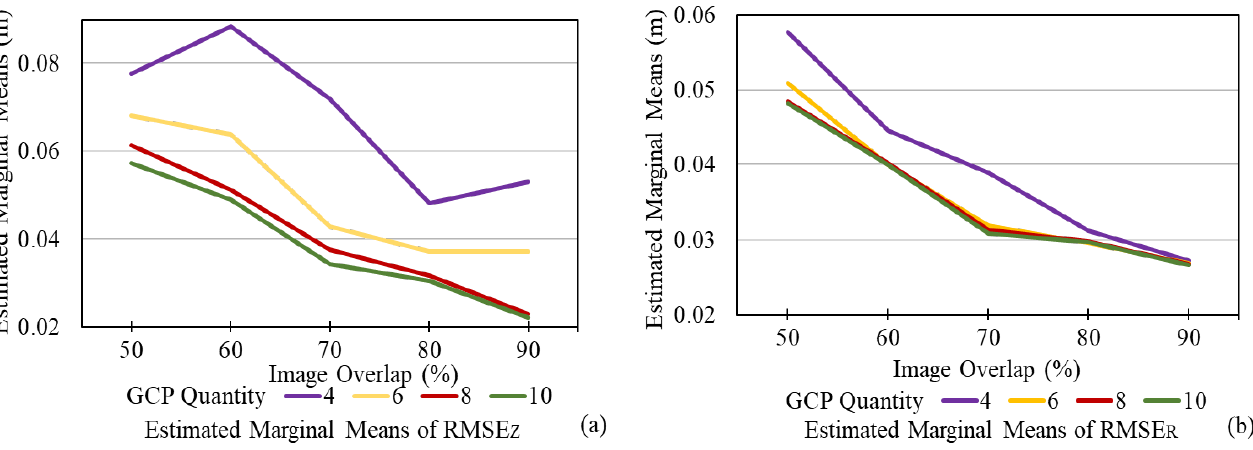
Figure 15. Interaction between Image Overlap and GCP Quantity; ( a ) RMSE Z ; ( b ) RMSE R .